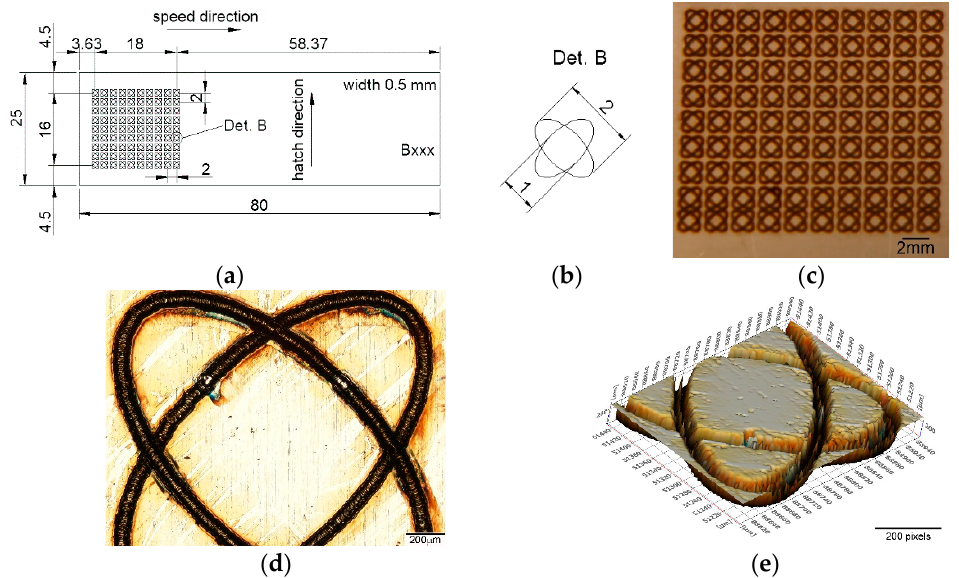
Figure 3. ( a ) Schematic representation of the test sample and pattern design type B, ( b ) detail of the pattern design B (all dimensions in mm), ( c , d ) macro and microscopic image, ( e ) 3D topographic image of LST design type B adapted from [39].